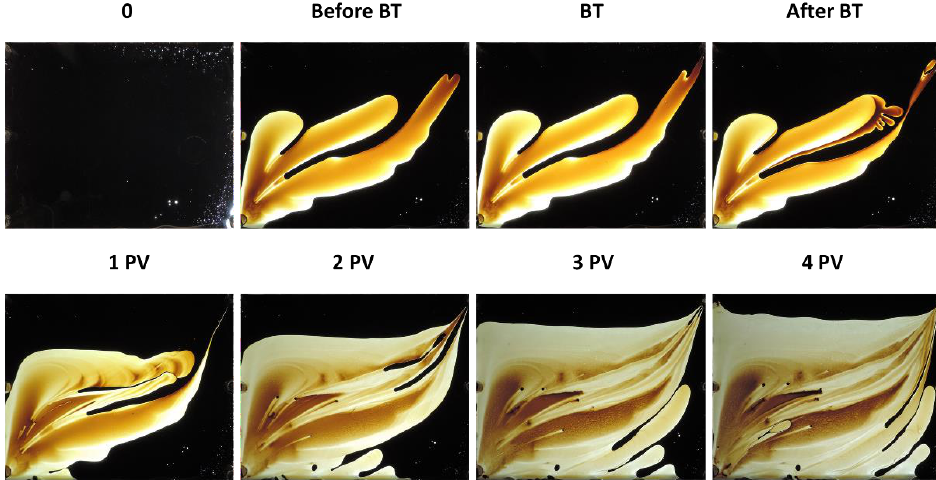
Figure 10. Crude oil displacement by polymer flooding at 0.3 mL/min.